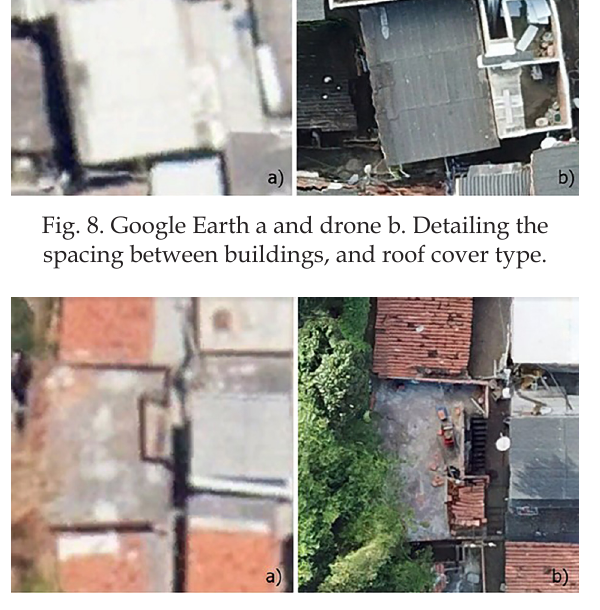
Fig. 9. Google Earth a drone b. Unprotected stairways and slabs became